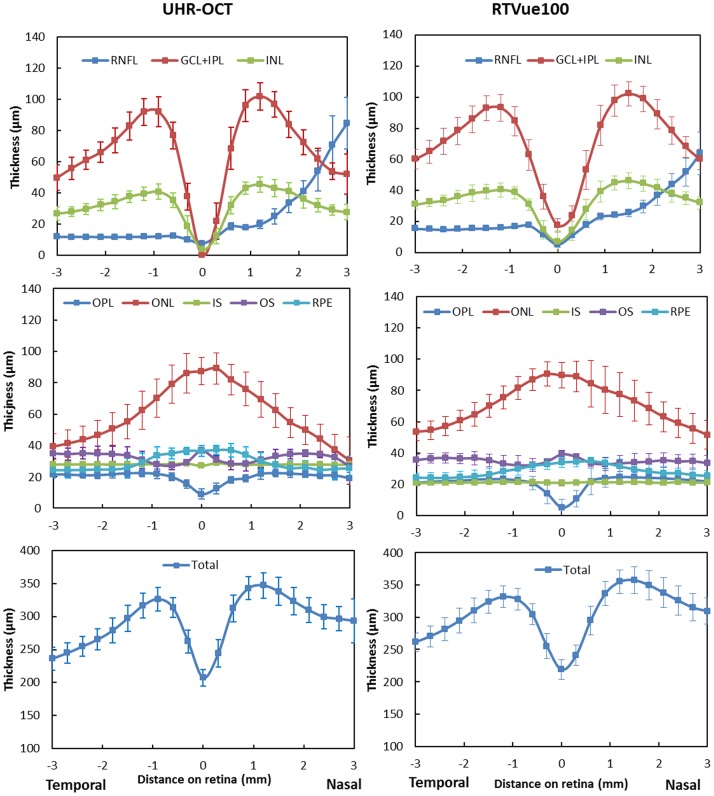
profiles of eight intra-retinal layers determined from the UHR-OCT and RTVue100 images in the horizontal meridian.Thickness profiles of eight intra-retinal layers along the horizontal meridian were averaged for 20 normal healthy eyes. Error bars represent standard deviation.